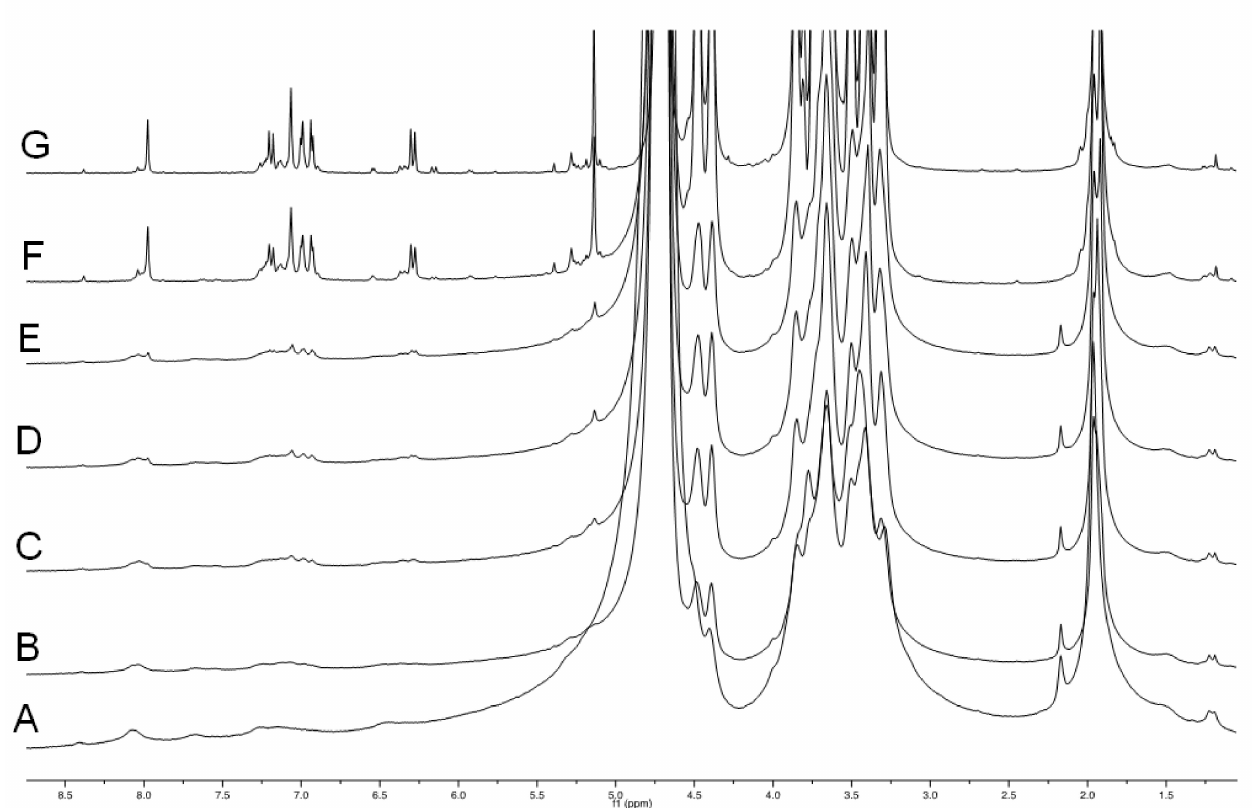
Figure 5. The comparison of 1 H NMR spectra obtained when a gel dispersion of HA(270)-FA-HEG- CL - 10 material in deuterated water was treated with NaOD at room temperature in an NMR tube, and 1 H NMR spectra were registered at regular time intervals. A: before the sodium hydroxide addition; B: immediately after the sodium hydroxide addition; C: after 10 min at room temperature; D: after 20 min at room temperature; E: after 30 min at room temperature; F: after 90 min at room temperature; G: after 24 h at room